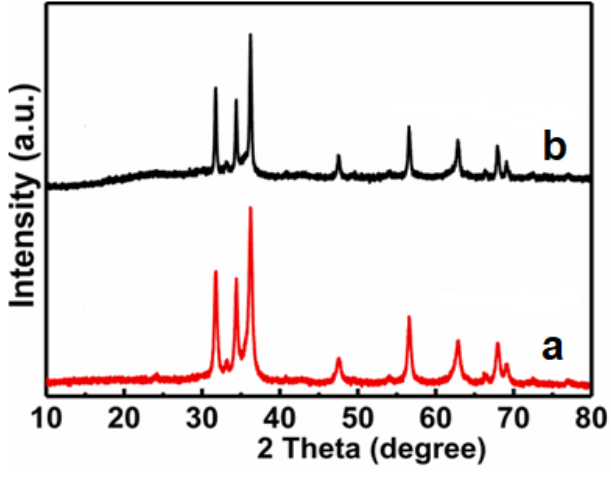
Figure 11. XRD patterns of ZnO/Fe 2 O 3 NFs ( a ) before and ( b ) after four cycles for photocatalytic degradation of MB.